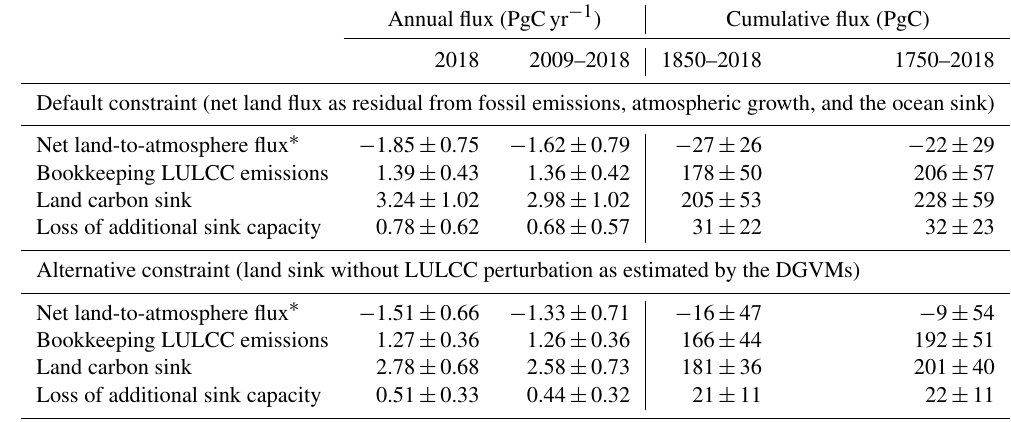
Table 2. Estimates of the global net land-to-atmosphere flux, LULCC emissions, land sink, and LASC. Estimates following our default (i.e., best-guess) and alternative constraints are provided. The land sink includes the LASC; therefore, the net land-to-atmosphere flux is strictly equal to the LULCC emissions minus the land sink.